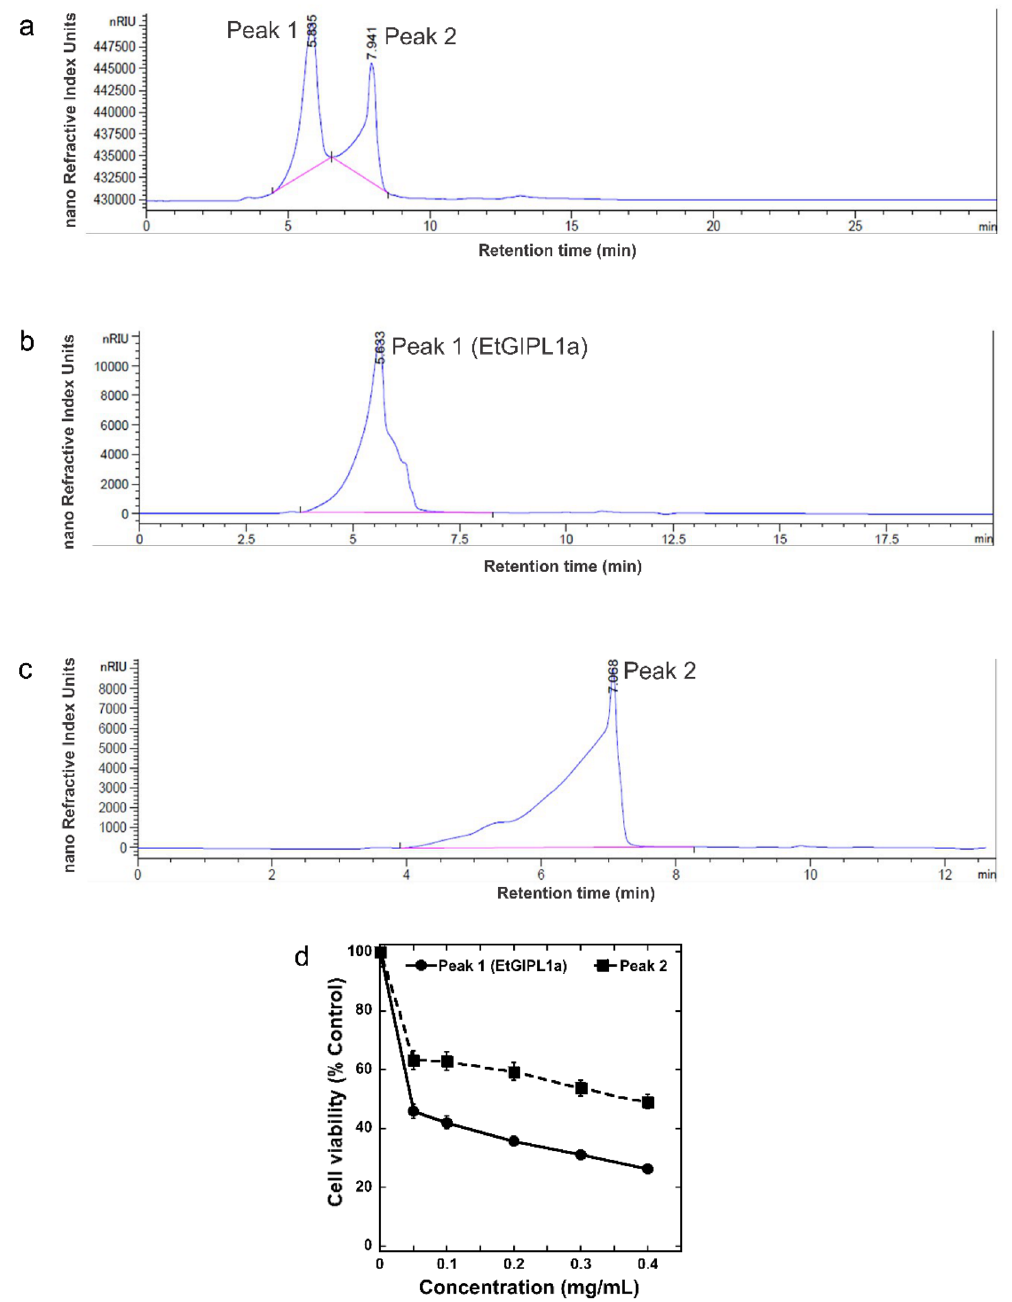
Figure 3. HPLC BioSEC-3 analysis of EtGIPL1a. Full elution profile of ( a ) L1a ( b ) Peak 1 (EtGIPL1a), and ( c ) Peak 2. The collected two peaks in ( b ) and ( c ) were assessed for anti-proliferative activity, as shown in ( d